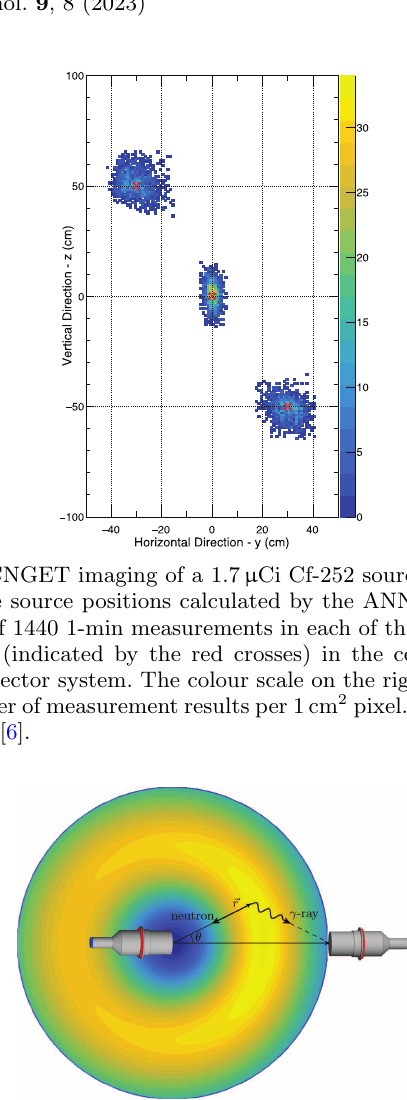
Fig. 2. Schematic illustration of the basic principle behind the Bayesian image reconstruction employed in ARCTERIX. The probability density function for the position of a fission event corresponding to the detection of a correlated neutron-gamma pair is mapped event by event. Taken from reference